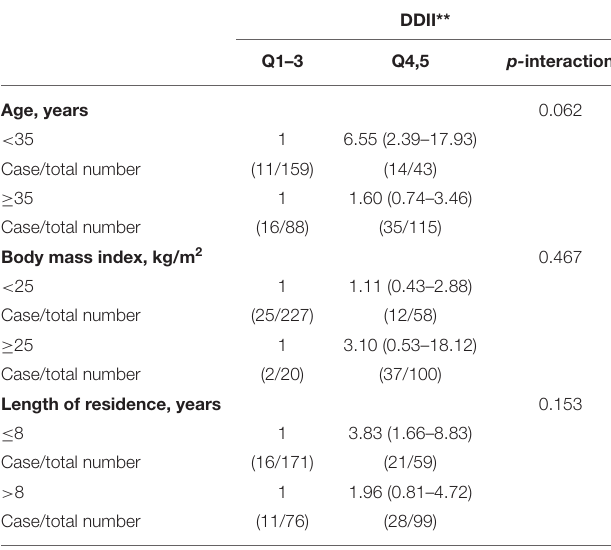
TABLE 6 | Subgroup analysis of the association of DDII with low-density lipoprotein cholesterols in the FiLWHEL